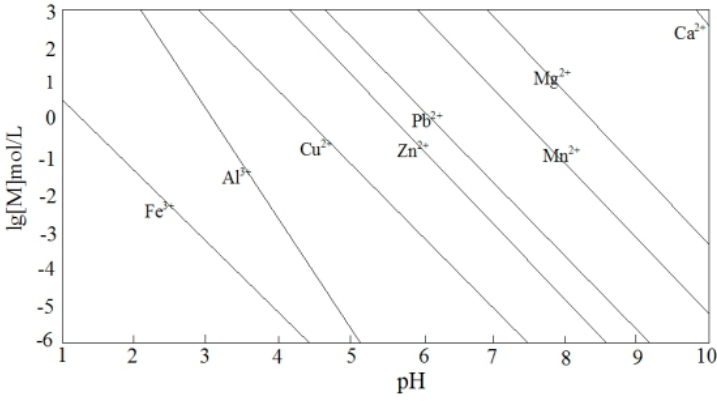
Figure 5. Relationship between equilibrium concentration of some metal ions and pH.